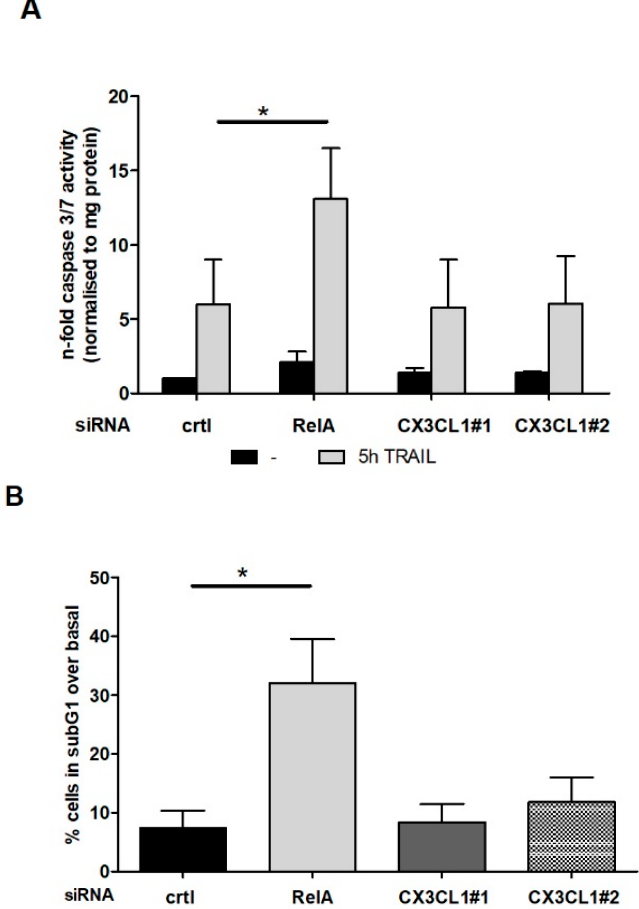
Figure 4. CX3CL1 does not directly affect TRAIL induced apoptosis in PDAC cells. Panc1 cells were